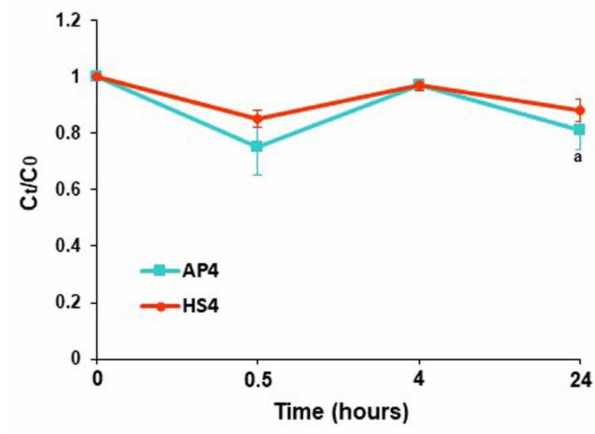
Figure 13. The serum proteins adsorption by AP4 and HS4 gel beads incubating for 24 h in Hanks’ solution supplemented with 10% FBS. The data are presented as the mean ± S.D. a p < 0.05 vs. the corresponding AP4 gel beads. The protein adsorption is expressed as the relative protein concen- tration C t /C 0 , where C 0 and C t are the initial and remaining concentrations in Hanks’ solution at different time points after incubation, respectively.